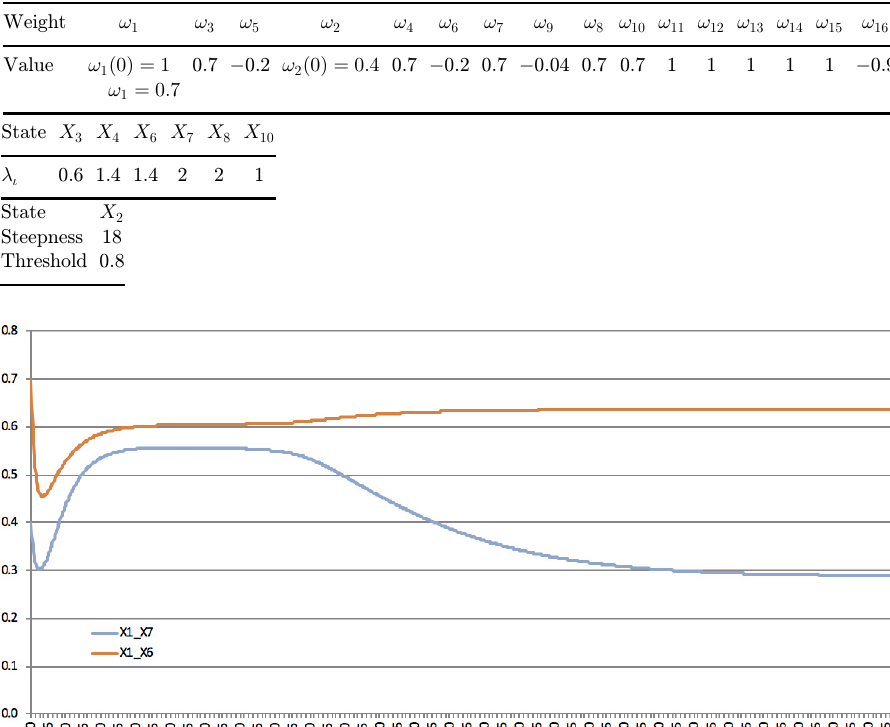
Table 5. Updated connection weights for the Scenario 4.